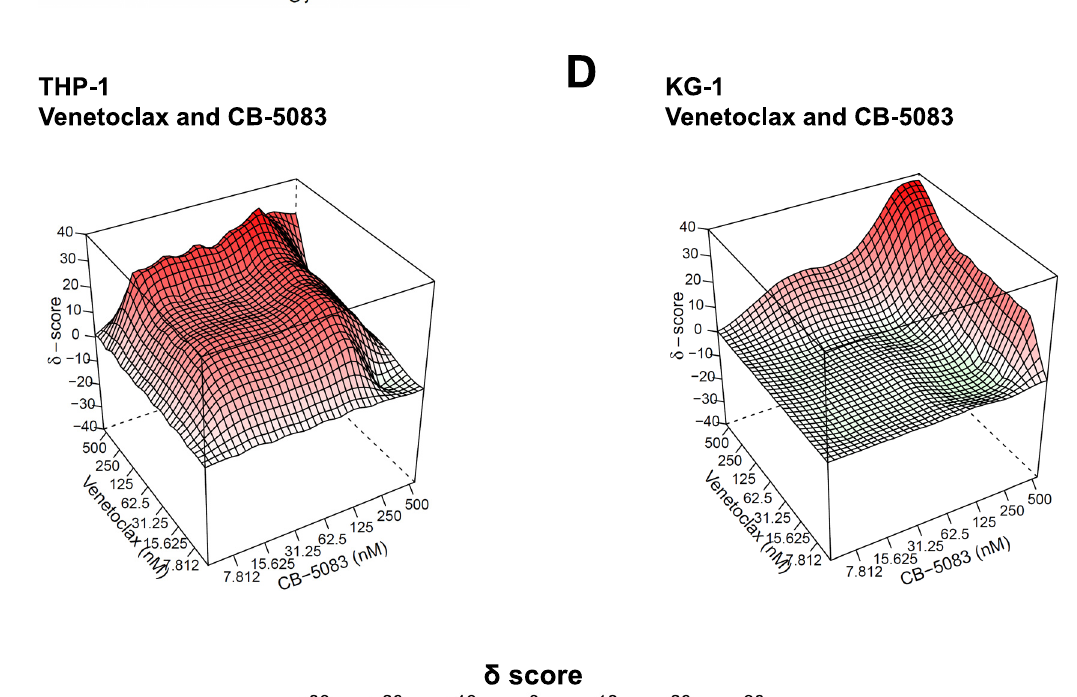
Fig 5. CB-5083 and cytarabine or venetoclax synergistically decrease AML cell survival. (A-D) THP-1 and MV4-11 cell survival was assessed in a 96-well format with increasing concentrations of CB-5083 and cytarabine or venetoclax. Following a 72-hour incubation, CellTiter-Blue Reagent was added and fluorescence/cell viability was assessed. Cell viability data was used as input for the SynergyFinder software to estimate synergy δ scores. Synergy landscape maps display δ scores for the indicated cells lines and drug combinations.